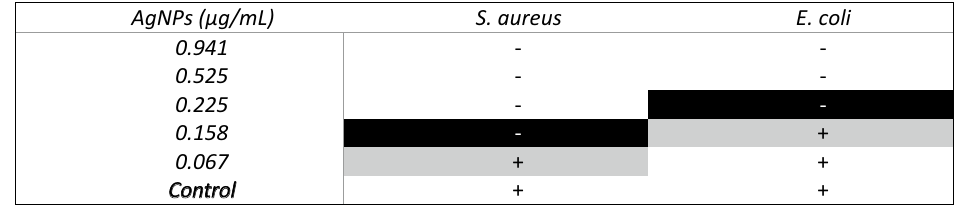
Table 1. Minimum inhibitory concentration and maximum effective concentration of AgNPs.